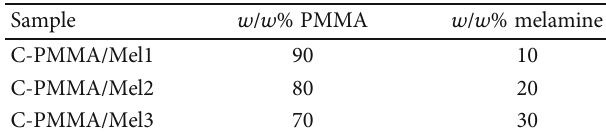
Table 1: Chemical compositions of PMMA and melamine for C- PMMA/Mel(1 –